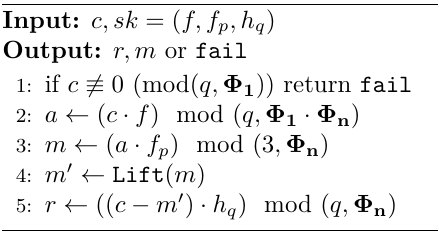
Algorithm 5 NTRU CPA Encryption